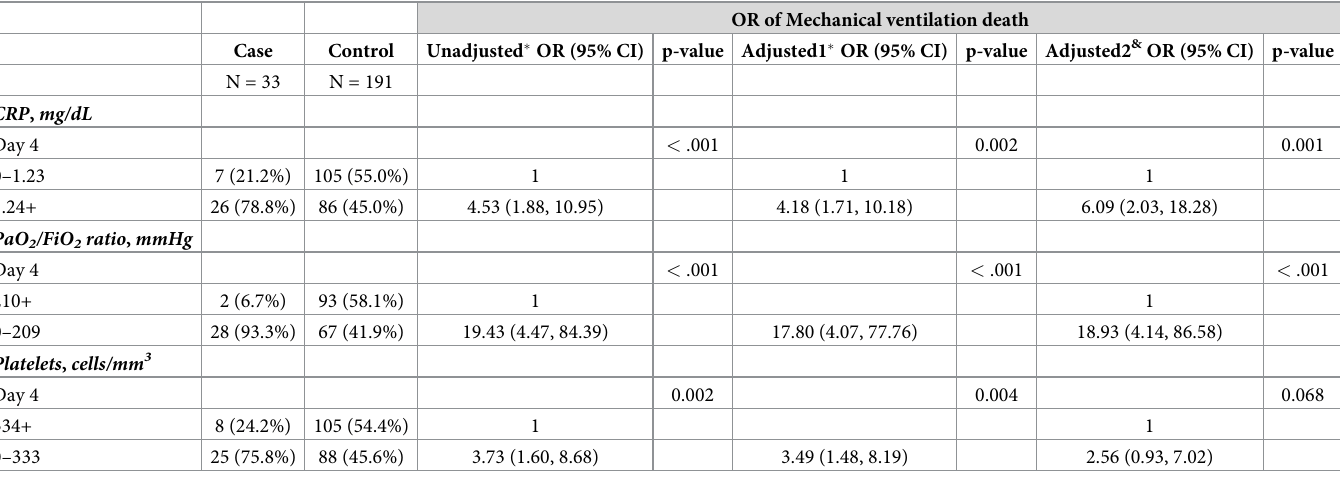
Table 3. OR from fitting a logistic regression